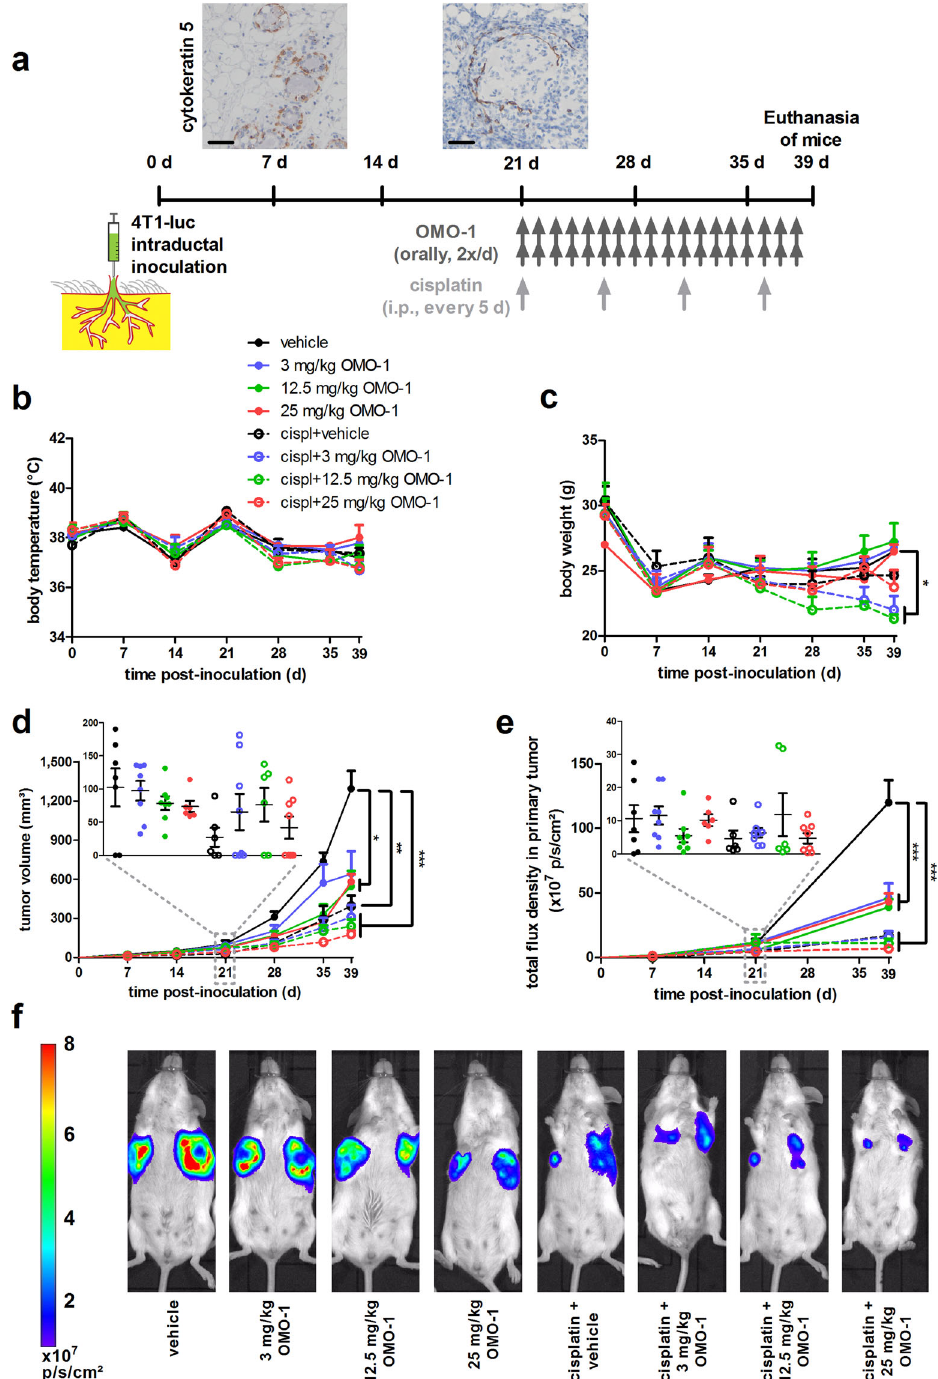
Fig. 1 OMO-1 treatment decreases primary tumor growth in a 4T1-based intraductal model. a Experimental timeline of the study, including immunohistochemistry for the myoepithelial cell marker cytokeratin 5 on primary tumor paraf fi n sections at 7 and 21 days p.i. Scale bar = 50 µm. Mouse body temperature ( b ) and weight ( c ) measurements (of the 29 included tumor-bearing mice, 4 mice were treated with vehicle, 4 mice with 3 mg/kg OMO-1, 4 mice with 12.5 mg/kg OMO-1, 3 mice with 25 mg/kg OMO-1, 3 mice with cisplatin + vehicle, 4 mice with cisplatin + 3 mg/kg OMO-1, 3 mice with cisplatin + 12.5 mg/kg, and 4 mice with cisplatin + 25 mg/kg OMO-1). d Primary tumor growth based on tumor volume measurements ( n = 7 for vehicle, n = 6 for 25 mg/kg OMO-1, cisplatin + vehicle and cisplatin + 12.5 mg/kg OMO-1, n = 8 for all other treatment groups at 39 days p.i.). Insert shows statistically nonsigni fi cant differences in primary tumor volumes between the randomized treatment groups at the start of treatment (i.e., 21 days p.i.). e Primary tumor growth based on in vivo imaging (measured as total fl ux density (p/s/cm 2 )) ( n = same as for tumor volume measurements, except n = 4 for 25 mg/kg OMO-1 at 39 days p.i.). Insert shows statistically nonsigni fi cant differences in total fl ux density in primary tumors between the randomized treatment groups at the start of treatment (i.e., 21 days p.i.). f Representative images of the in vivo bioluminescence signals at 39 days p.i. in each treatment group. Data in b – e are presented as the means ± standard error of the mean (SEM). * P < 0.05, ** P < 0.01, *** P <